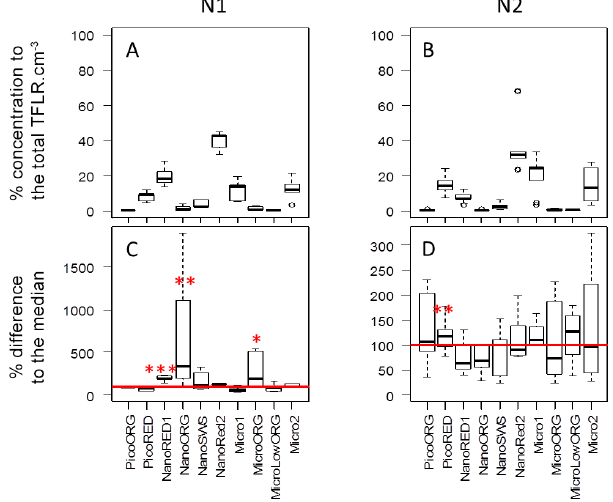
Figure 10. (a, b) The clusters’ proportional contribution to the to- tal TFLRcm − 3 within each PHYSAT anomaly (N1 and N2). (c, d) Within each anomaly, the clusters’ TFLRcm − 3 proportional differ- ence to its median value calculated on the entire matching points data set. Wilcoxon rank test was run for each cluster between the two anomalies. *** p <0.001; ** p <0.01; * p <0.1.